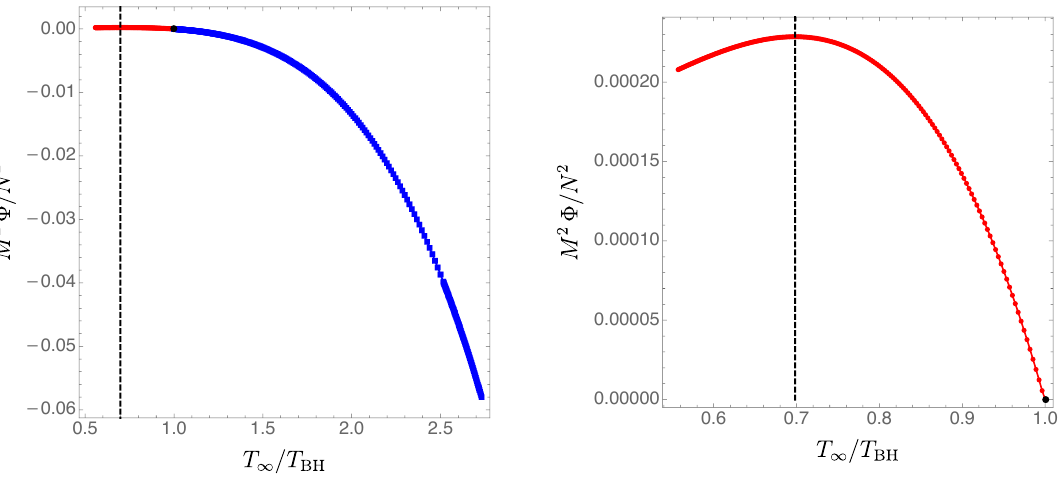
Figure 4 . Hawking (cid:13)ux (cid:8) plotted as a function of T 1 =T BH . The right panel shows a zoom of the left panel in the region T 1 =T BH (cid:20) 1. (cid:8) does not appear to behave monotonically in T 1 =T BH , and in particular it has a maximum at T 1 =T BH (cid:17) (cid:28) max (cid:25) 0 : 698282, which is marked as a vertical dashed line in both left and right panels. The red disks indicate when (cid:8) > 0, and the blue squares when (cid:8) < 0. The Hartle-Hawking state is represented by a black disk.